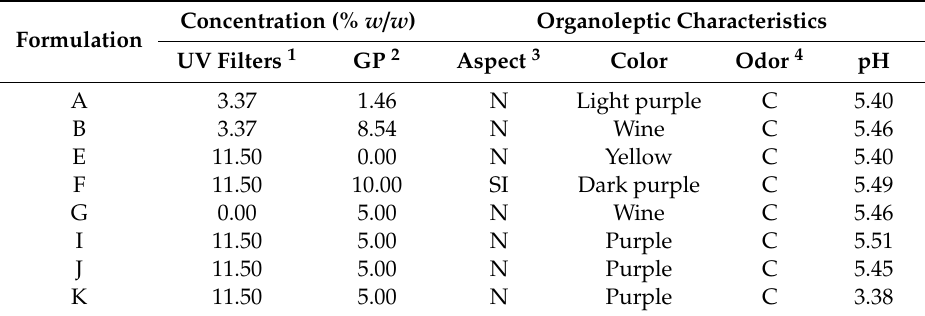
Table 4. Physical and physicochemical characterization of formulations with and without grape pomace ( V. vinifera L.) after 24 h of